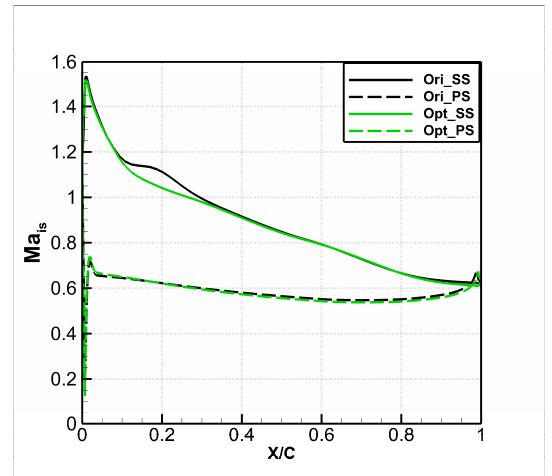
Figure 16. Isentropic Mach number on 70% of the span height of second-stage rotor of the original and optimized compressor.